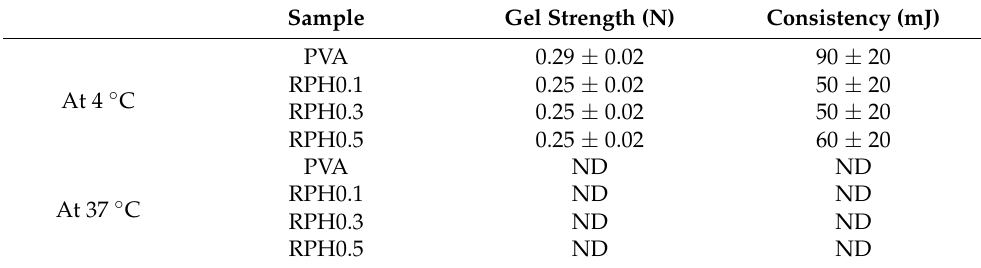
Table 1. Gel strength (N) and consistency (mJ) of the retinol-loaded PVA hydrogel.